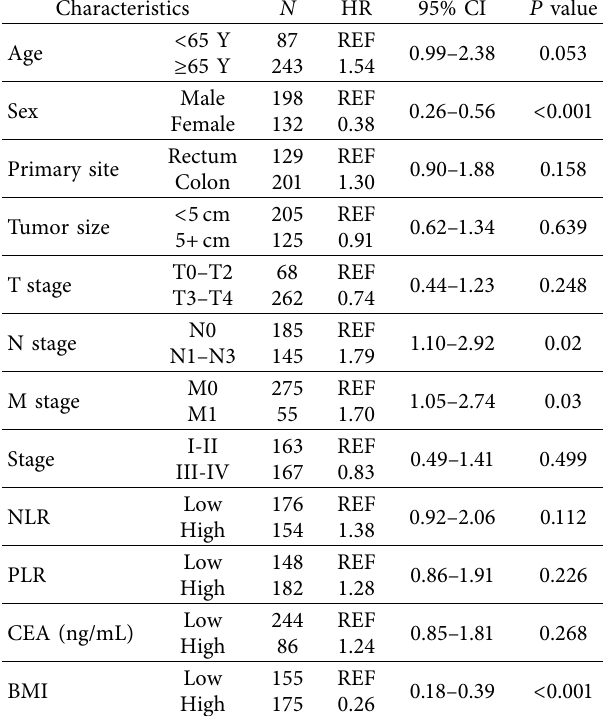
Table 5: Multivariate analysis of overall survival by the Cox proportional hazards